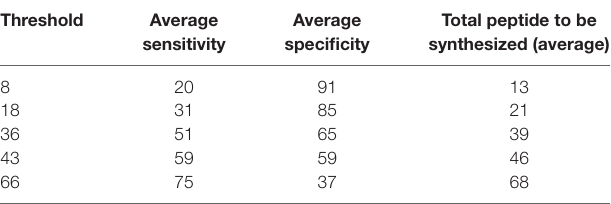
TaBle 2 | Performance of overlapping dataset derived from literature at different threshold settings using the percentile combined score. Threshold average average Total peptide to be sensitivity specificity synthesized (average)